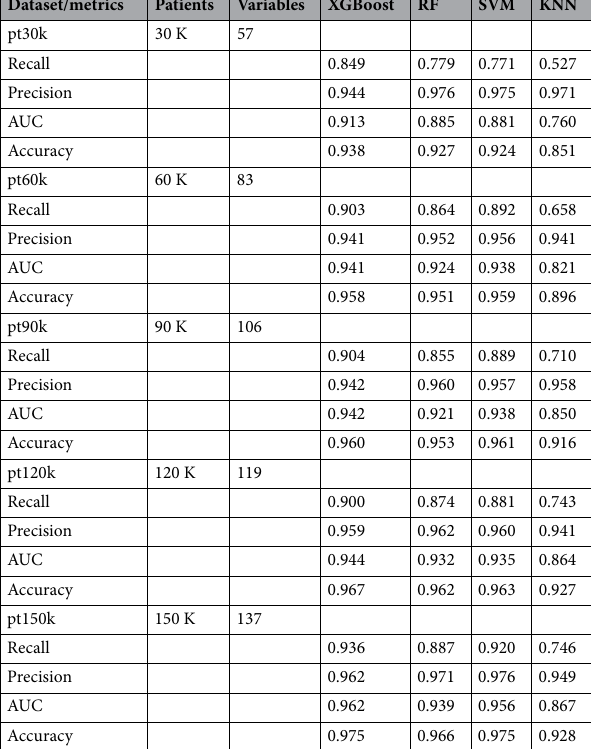
Table 1. Continuous update of patient datasets and improvement of lung cancer risk prediction XGBoost base models in the simulated learning health system. Initial dataset: 30 K patients; 4 data updates, each with additional 30 K patients. The XGBoost base model was also compared to RF, SVM and KNN base models at the time of each data